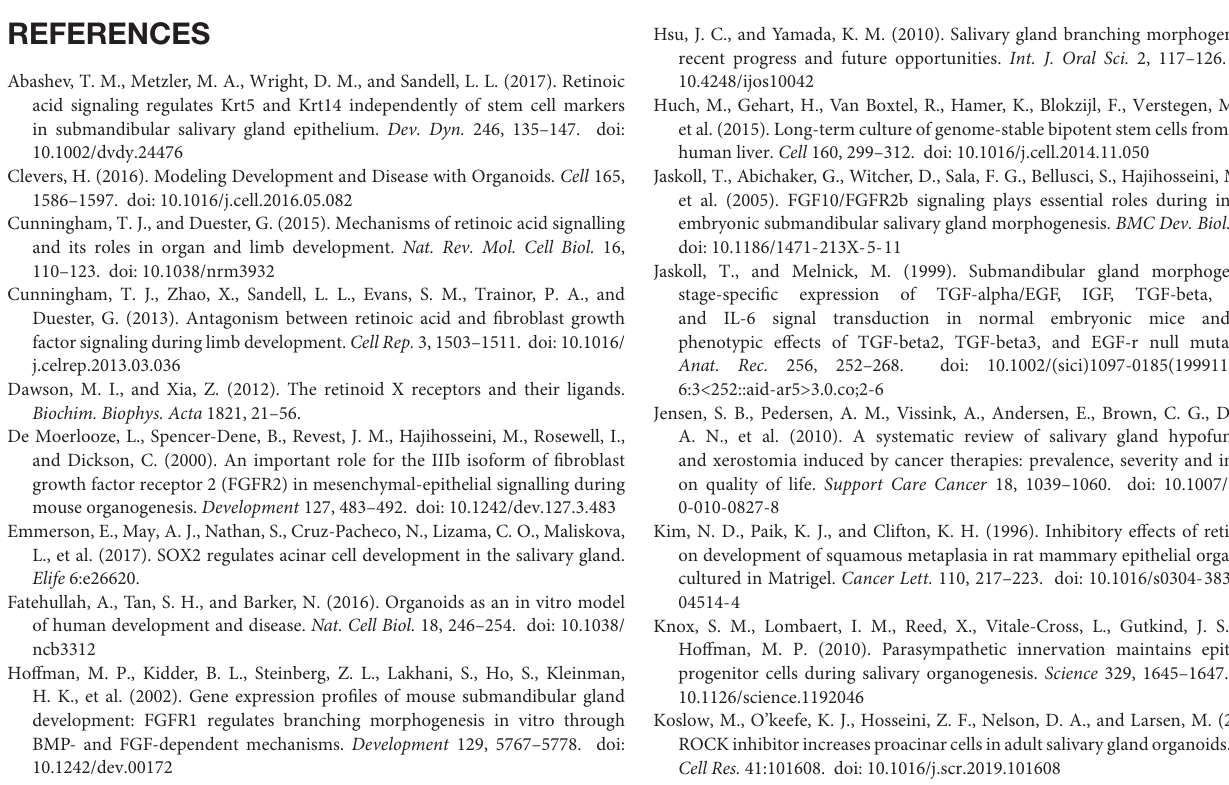
Supplementary Figure 1 | Expressions of basal and luminal cell markers in salivary gland organoids. (A) Maximum intensity projected images of organoid at day 7 (up) and day 9 (down). Organoids were subjected to immunofluorescence for KRT5 (white), KRT19 (green), KRT7 (red), and DAPI (blue). Scale bar indicates 50 µ m. (B) SMG organoids were harvested on days 5 and 9, and 200 nM of VIP was treated on the last 1 day. Harvested organoids were subjected to qRT-PCR to evaluate the expressions of Krt5 , Krt19 , and Krt7 ( n = 3). Results are expressed as the mean ± SEM. ∗ p < 0.05. Supplementary Figure 2 | FGF-induced complex structure is observed in salivary gland organoids. SMG organoids were cultured in combination with 1 nM bFGF and 5 nM FGF10 throughout the culture. (A) FGF-induced changes in morphology were observed via brightfield microscopy in salivary gland organoids. Scale bar indicates 500 µ m. (B) Organoids were subjected to immunofluorescence for KRT5 (green) and KRT7 (red). Nuclei were counterstained with DAPI (blue). Scale bar indicates 50 µ m. Supplementary Figure 3 | VIPR1 expression in salivary gland organoid. The mouse SMG organoids cultured with RA were subjected to immunofluorescence for the evaluation of VIPR1 (green), ACTA2 (magenta), and MIST1 (cyan) expressions. Nuclei were counterstained with DAPI (white), and each single channel image was placed below. Scale bars indicate 50 µ